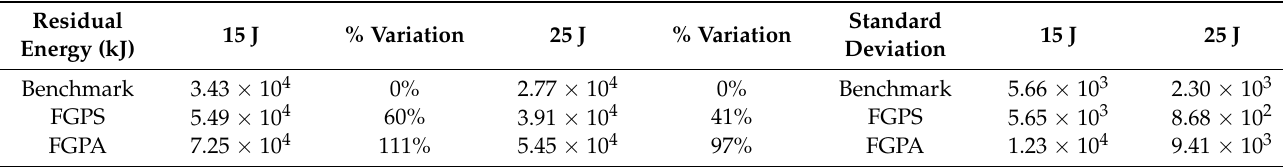
Table 4. Data for the FAI tests reporting the mean of the residual energy (kJ) and relative variation from the benchmark for each configuration (FGPS and